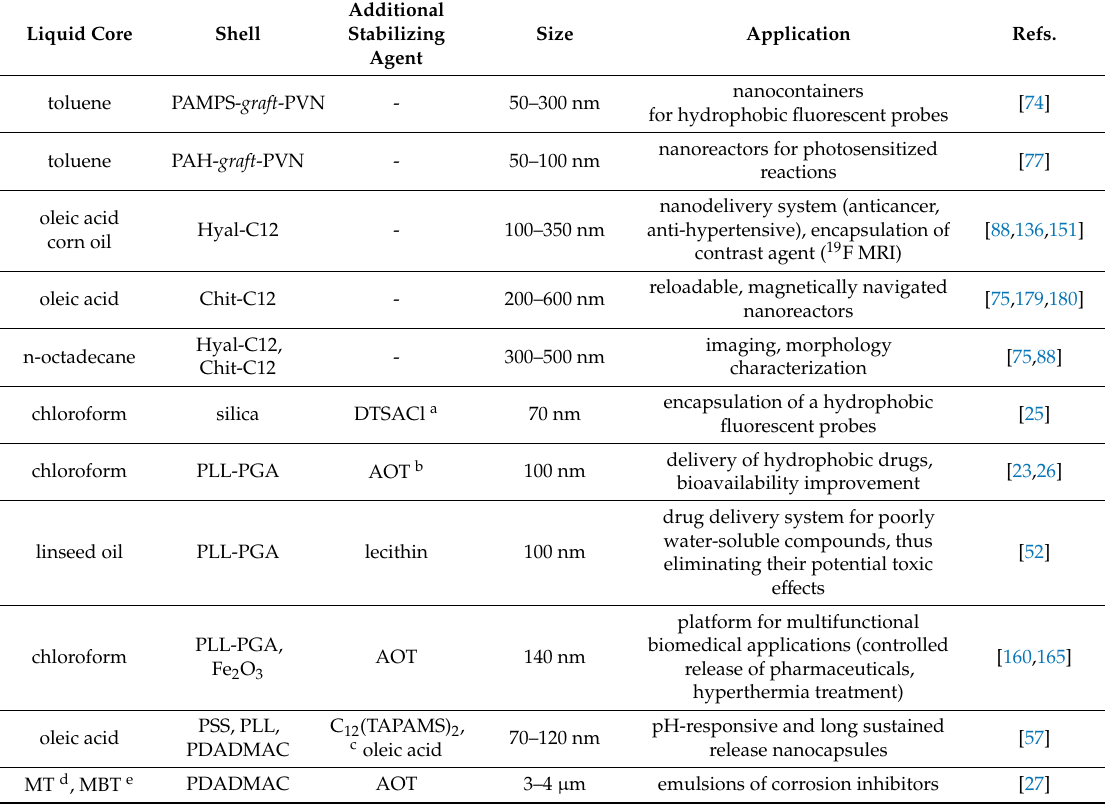
Table 1. Brief summary with the most important properties of the oil-core